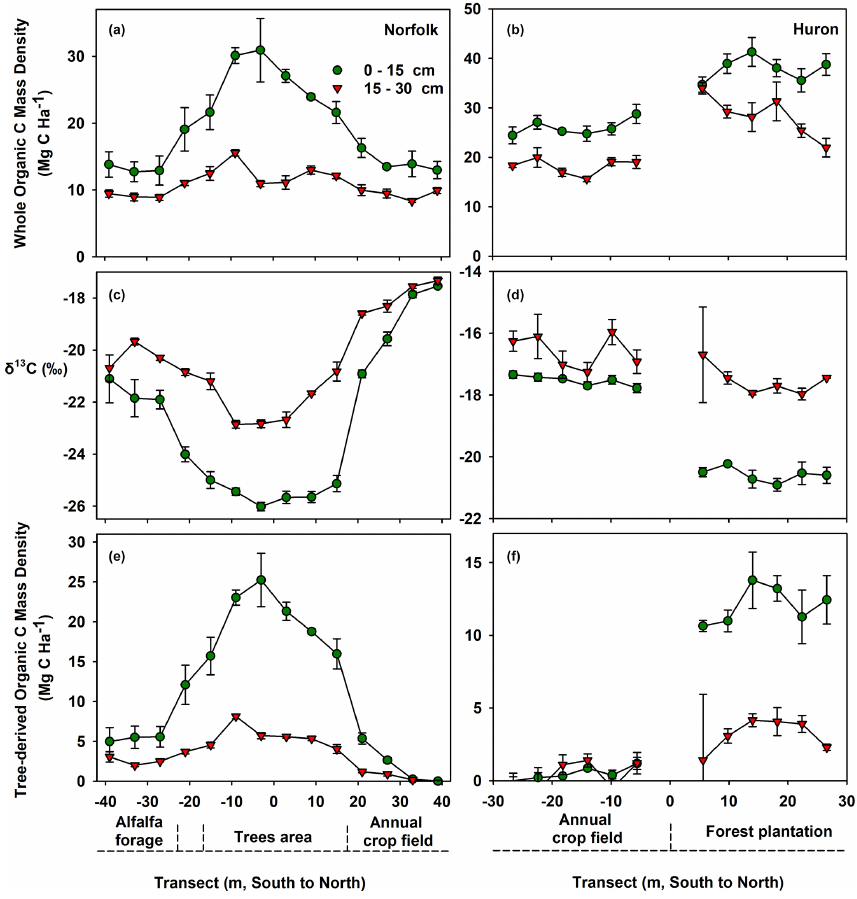
Figure 4. (a, b) Soil organic carbon mass storage, (c, d) stable isotope ratios of organic C ( δ 13 C) and (e, f) organic C mass derived from C 3 plants across transects at Norfolk shelterbelt (a, c, e) and Huron forest plantation (b, d, f) for the 0 to 15 and 15 to 30cm soil depth increments. Adjacent cropped fields were also included. Within the afforested areas in panels (e) and (f) , the reported organic C masses are primarily attributed to direct tree contributions. Contributions of tree-C to soil C storage were clearly discernable within the 0 to 15cm depth increment. Note the difference in vertical y scales across panels. Error bars are standard error of the means, with sample sizes of 4 for Huron and 3 for Norfolk. Table 3. Soil organic carbon storage within the 0 to 15cm depth increment contrasting annual croplands and afforestation in the United States. Sources of soil C storage beneath the trees were allocated as tree C versus remaining prairie C using Eqs. (4) and (5) and associated assumptions. Error bars are standard error of the